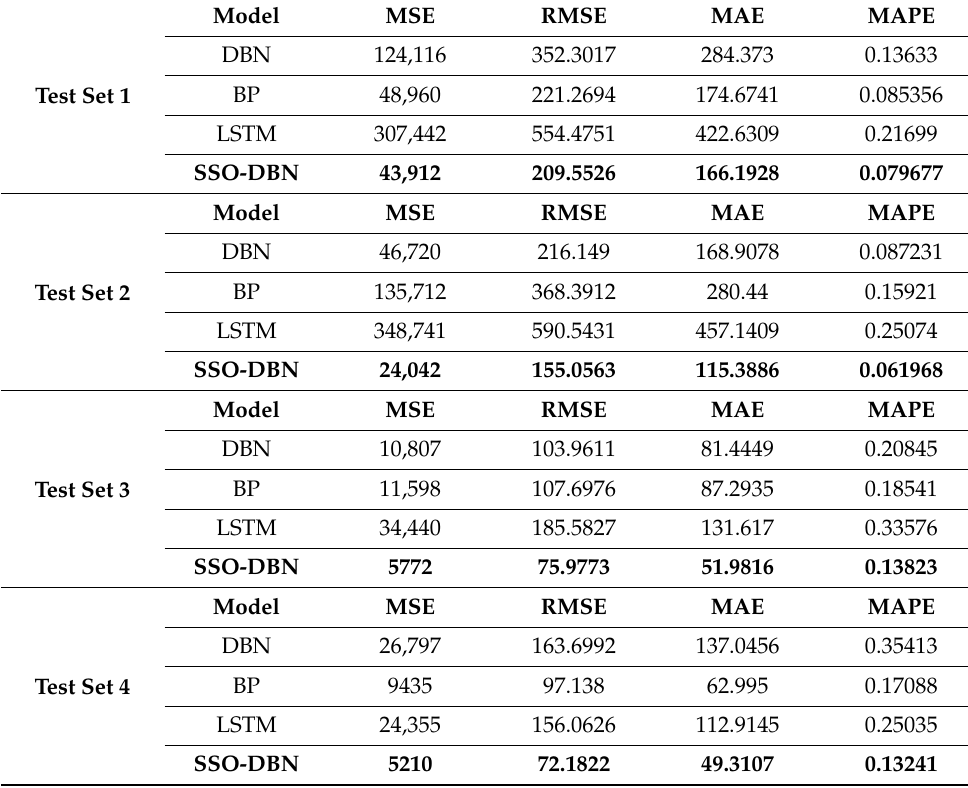
Table 4. Prediction results of evaluation index